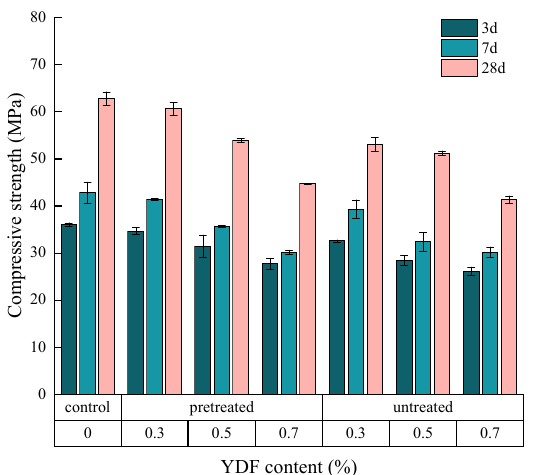
Figure 7. Effects of YDF content on the compressive strength of cementitious mortars.